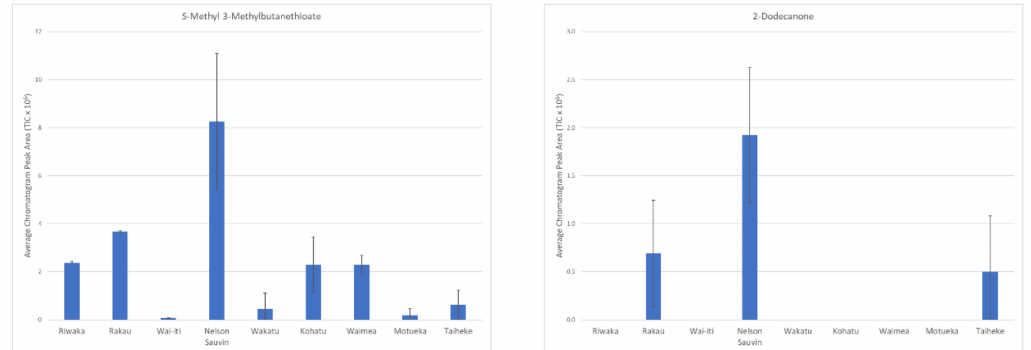
Figure 5. Bar graphs of discriminant compounds found in the Nelson Sauvin cultivar showing the compound abundance in each of the hop cultivars measured (TIC × 10 6 ). Error bars represent standard